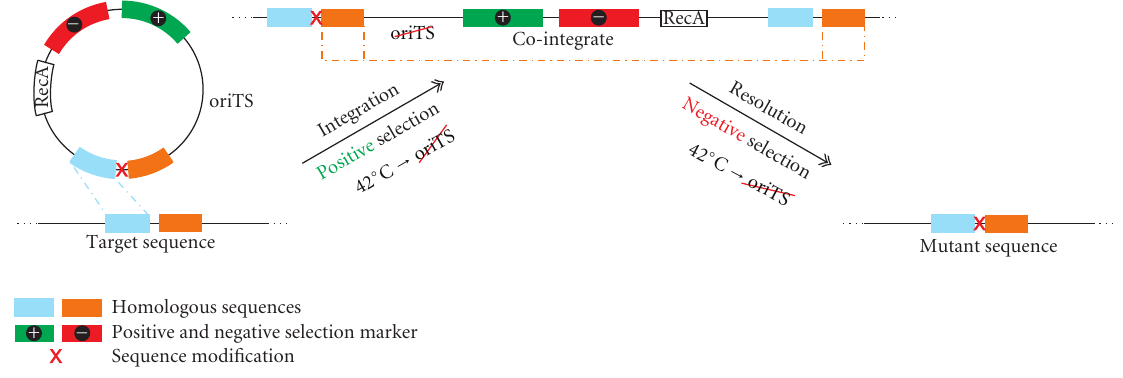
Figure 1: Schematic illustration of shuttle mutagenesis. In a first step, a shuttle plasmid is inserted into the target sequence via RecA-mediated recombination of homologous sequences. Replication of the shuttle plasmid containing a temperature sensitive origin (oriTS) is repressed by a temperature increase to 42 ◦ C. Positive co-integrates are selected with corresponding antibiotics. In a second step, vector sequences are excised from co-integrates by another recombination. Negative selection markers can be used to select BAC constructs that lost the shuttle plasmid [28, 64]. Dotted lines symbolize recombination